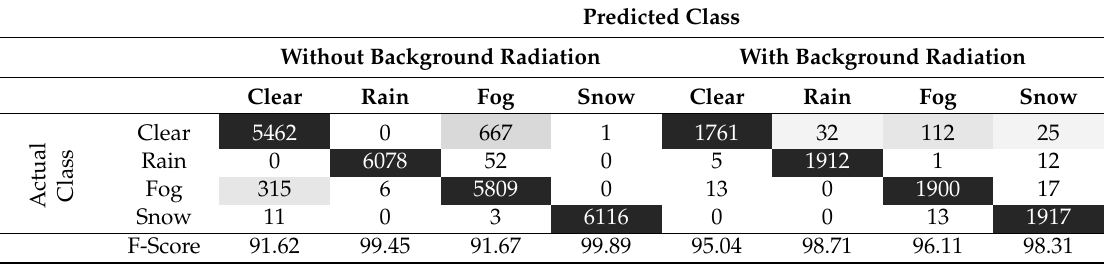
Table 6. Confusion matrix for the street region without background radiation (left, 6130 samples